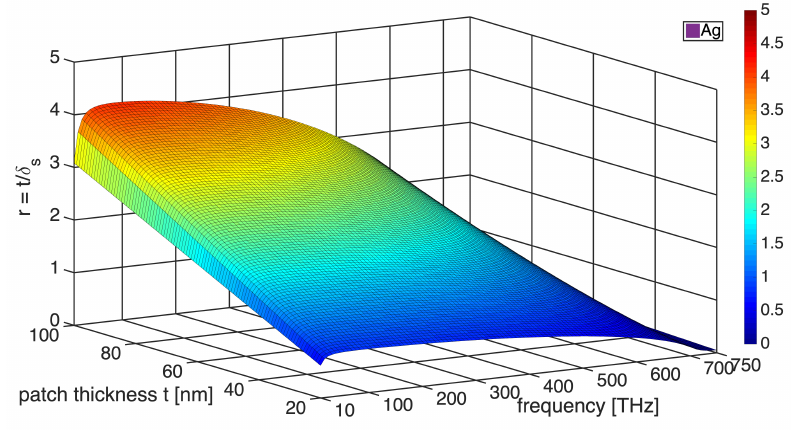
Figure 7. A 3 D representation of the ratio r = t / δ s ( δ s : penetration depth, t : thickness of metallic portions) for Ag at 10–750 THz frequency range. The color scale represents the values of the ratio r .